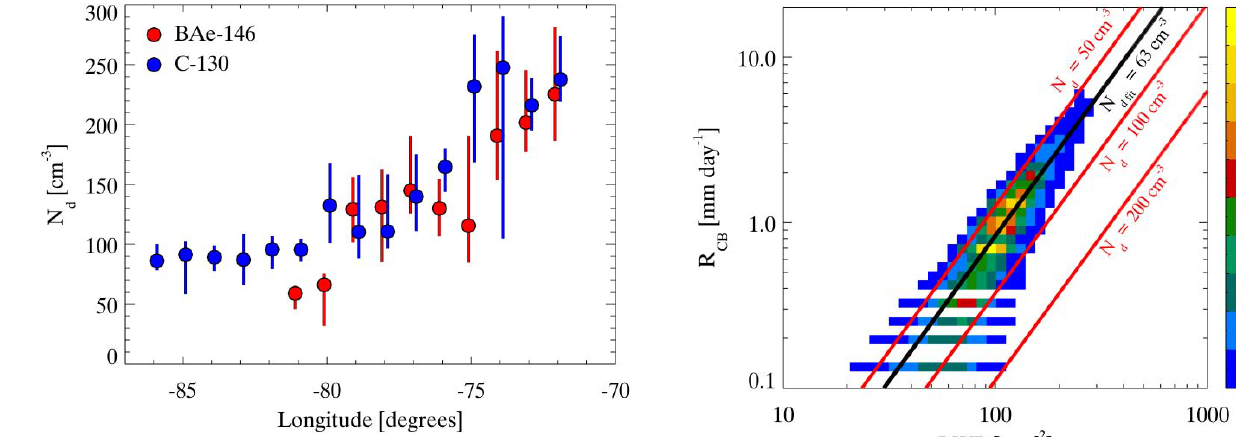
Fig. 10. Histogram of rain rate at cloud base as a function of LWP. The histogram is normalised so that the peak value is 1.0. Data are taken from the MetUM forecast from 14 October to 19 November 2008 in the region 15–25 ◦ S and 80–90 ◦ W. The red lines show the Comstock et al. (2004) relation for cloud droplet number concentra- tions of 50, 100 and 200cm − 3 . The black line is a fit to the MetUM